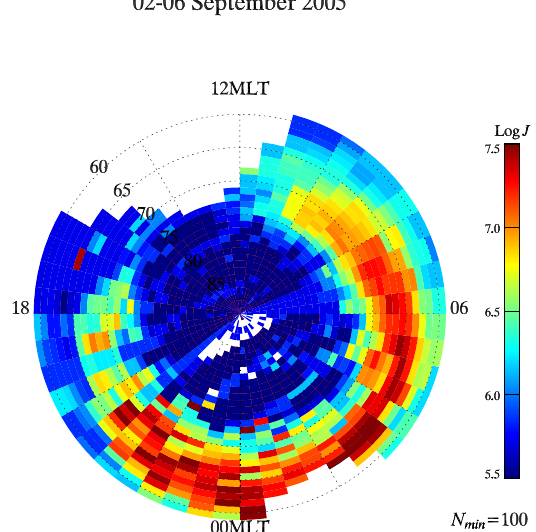
Fig. 13. MLAT-MLT map for median spectral width of TIGER data calculated for 2–6 September 2005 (all data were converted to f 0 = 11.5MHz). Minimum number of data points per bin was N min = 100.